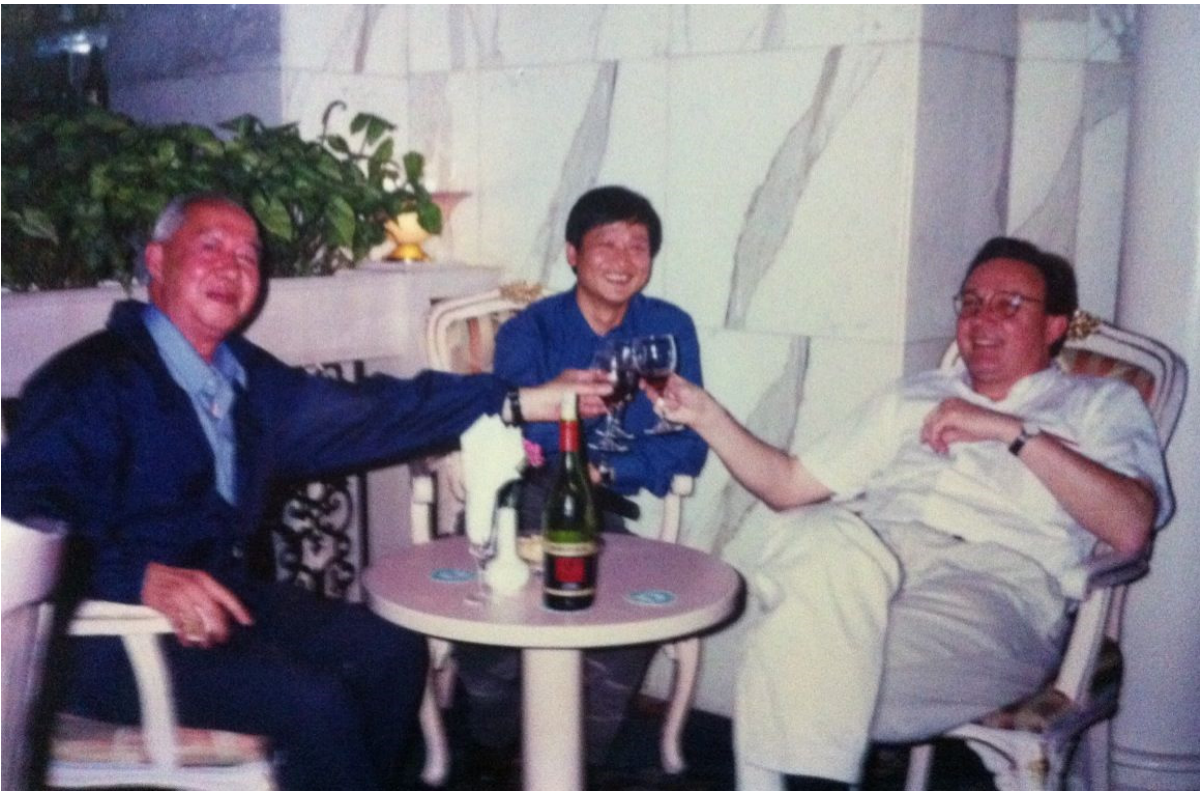
Figure 3. Professor Tanner (right) together with his Chinese friends Professor Shu-Hua Xiao (left) and Dr. Jiagang Guo (middle) in Shanghai in 2001.